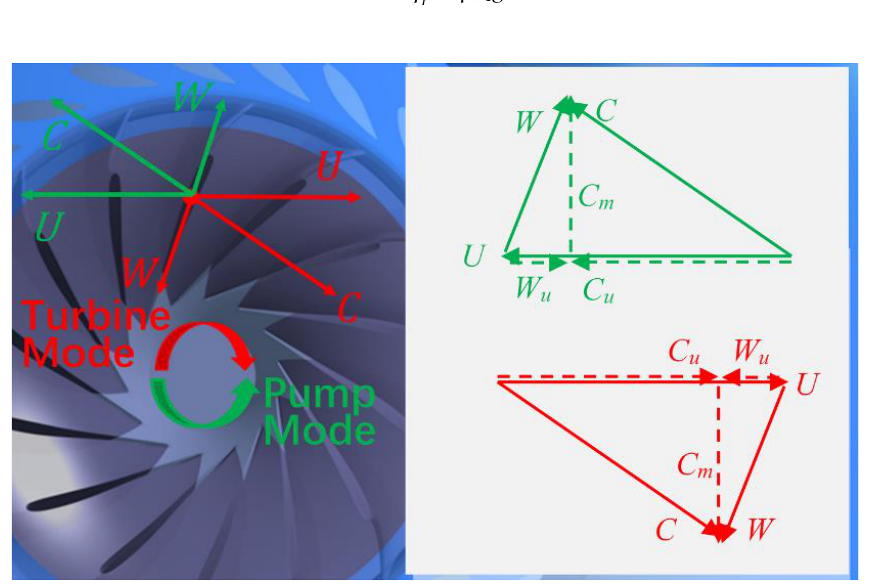
Figure 3. Velocity triangles of the bladed hydraulic machinery’s runner in the turbine mode and pump mode.